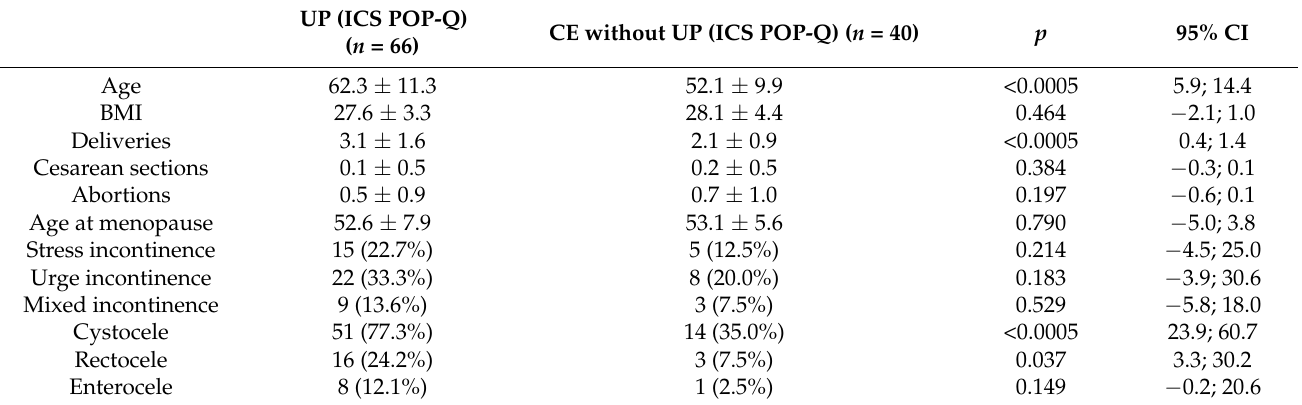
Table 1. General and clinical data of patients assessed and classified according to the presence of uterine prolapse (UP) or cervical elongation (CE) without